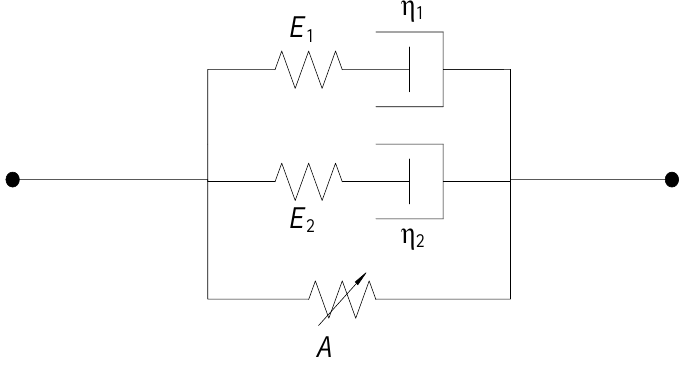
Figure 1. The “Zhu– Wang –Tang” constitutive model. Figure 1. The “Zhu–Wang–Tang” constitutive